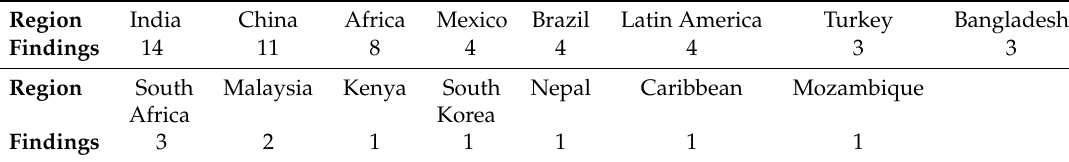
Table 1. Nominated regions.